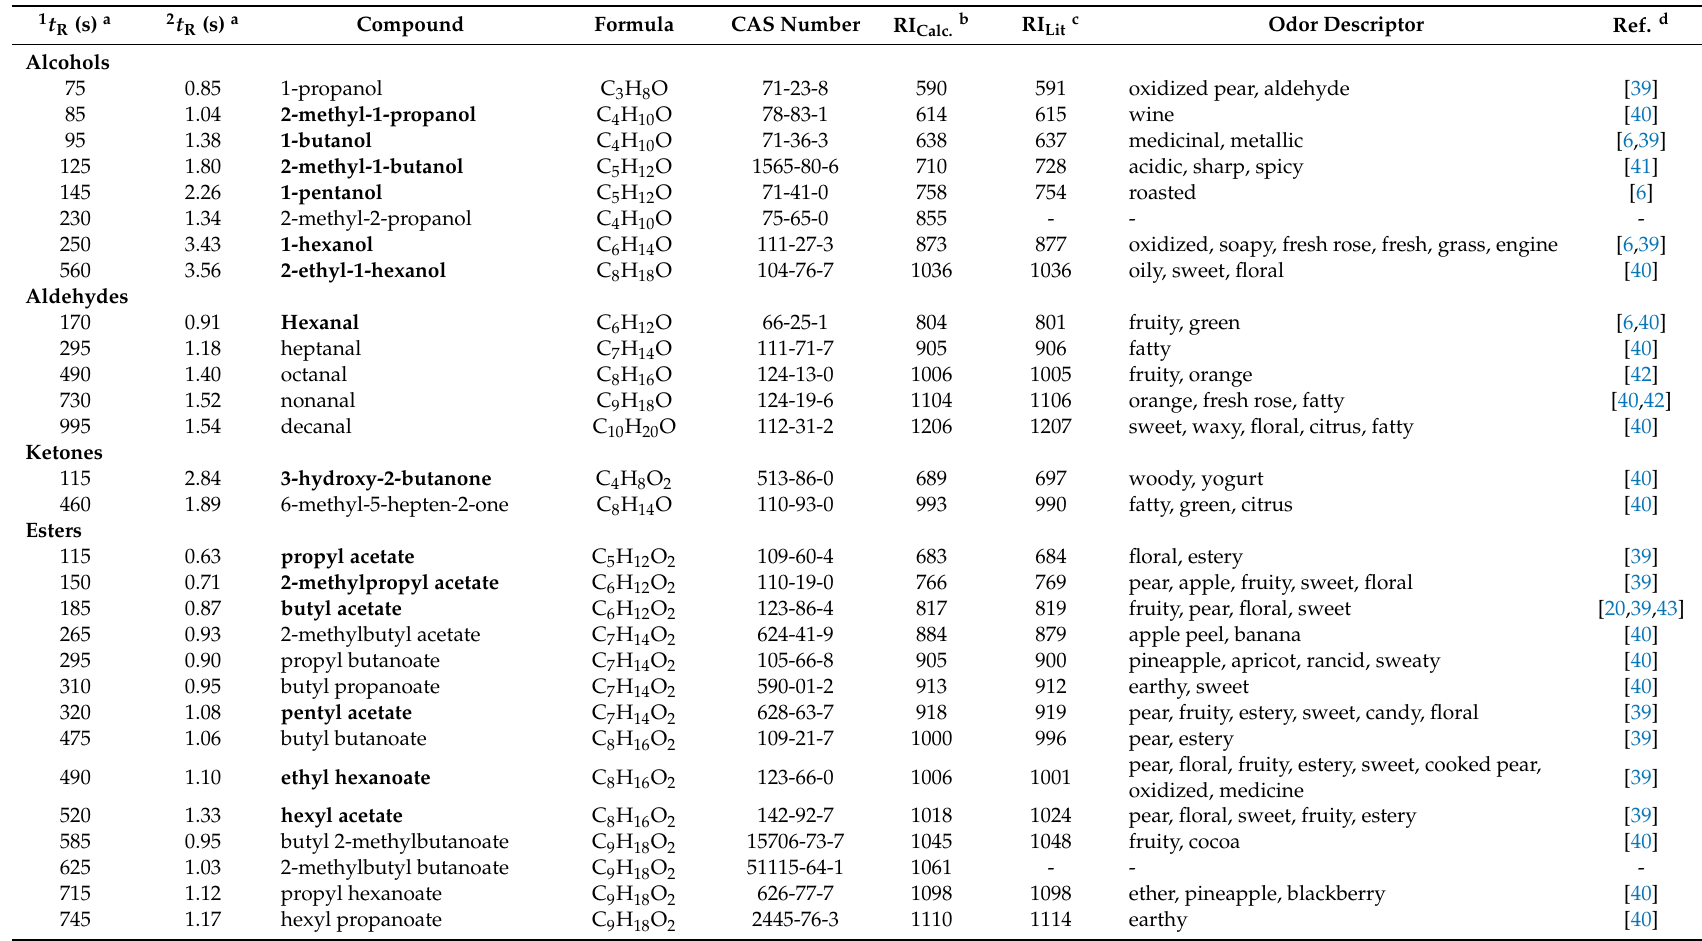
Table 1. List of the 57 selected compounds of the “Rocha” pear volatile profile, using HS-SPME / GC × GC-ToFMS, including relevant chromatographic data used to assess compounds identification and respective odor descriptors. More details, including chromatographic data, are available in Table